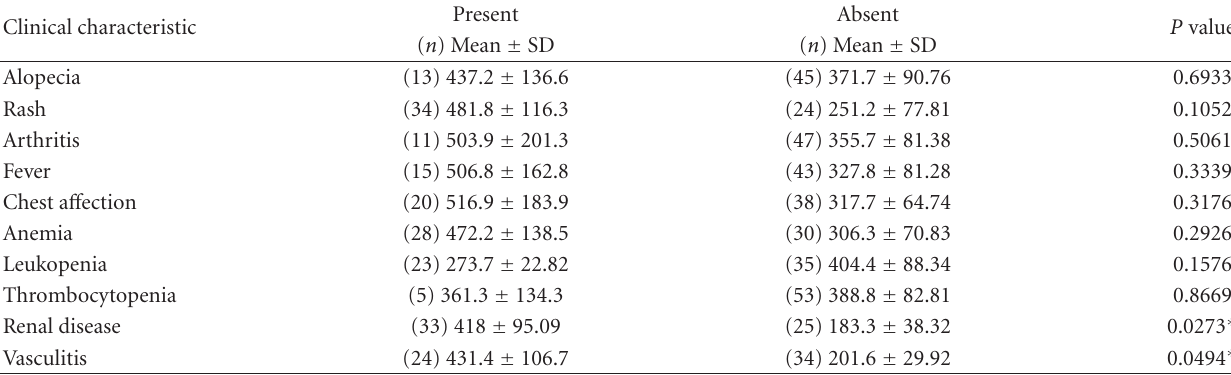
Table 3: Serum GITRL level in SLE patients with or without clinical characteristics.